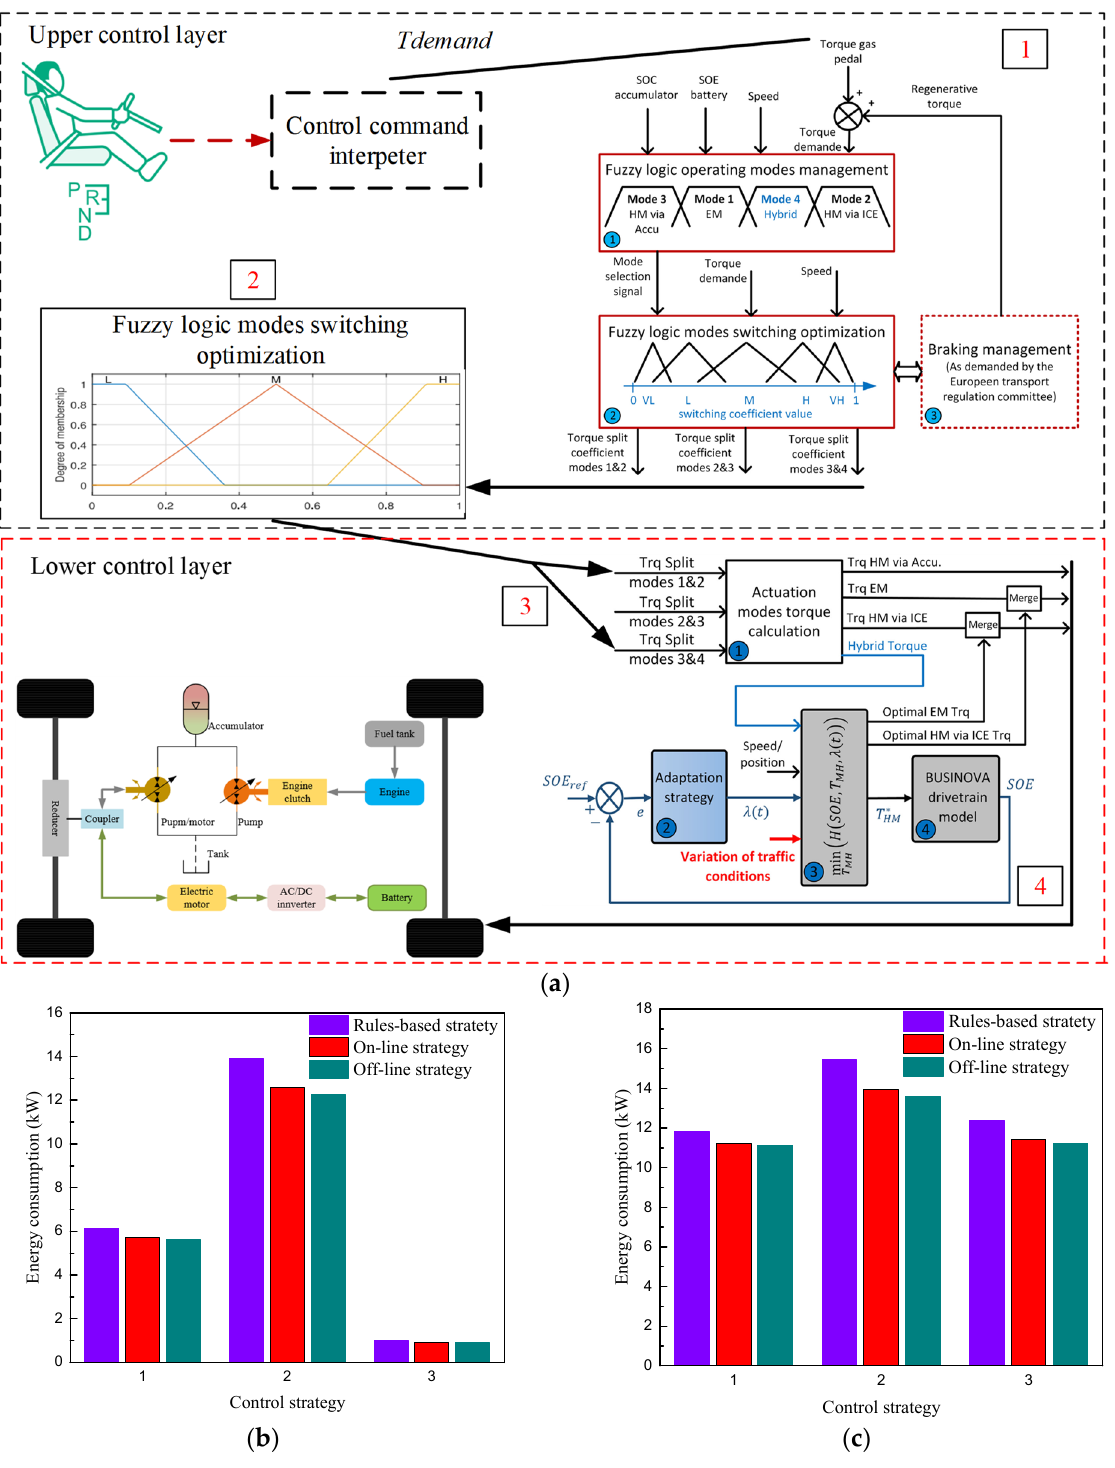
Figure 23. Proposed control strategy and results of the hybrid hydraulic–electric system [90]: ( a ) control strategy for BUSINOVA bus; ( b ) comparison of three strategies under UDC; ( c ) comparison of three strategies under FTP ‐ 75.